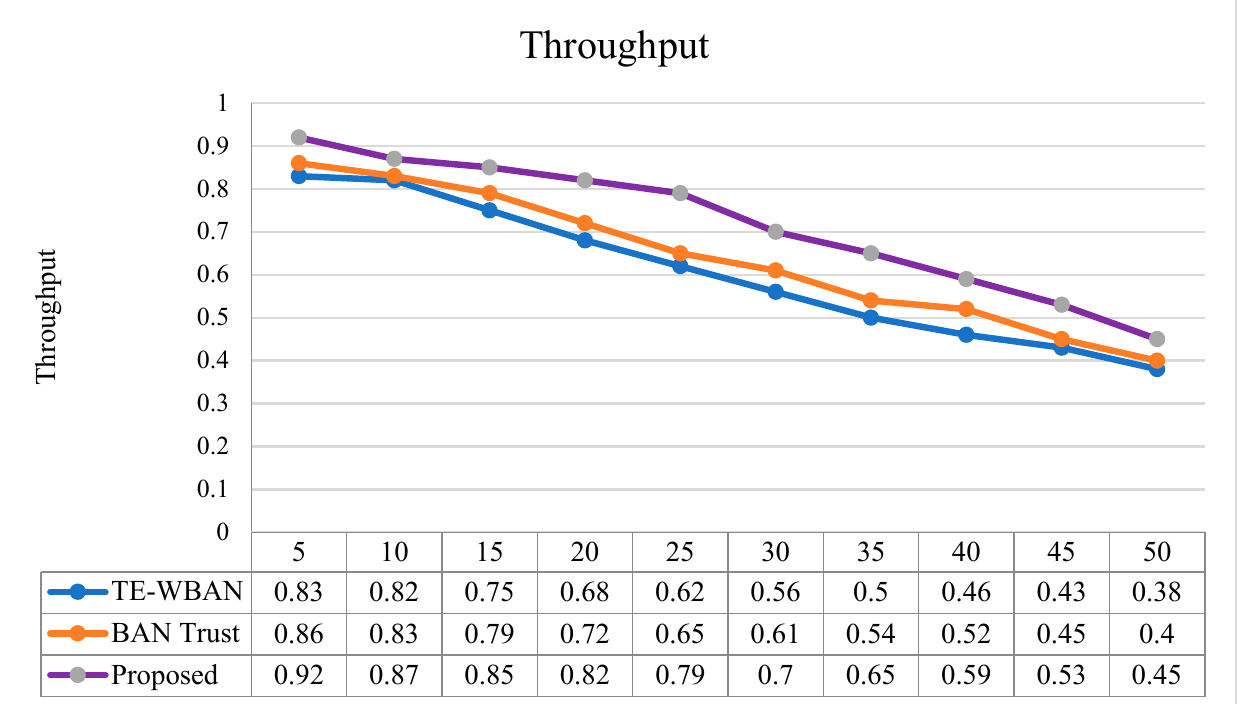
Figure 1. Throughput vs. Malicious